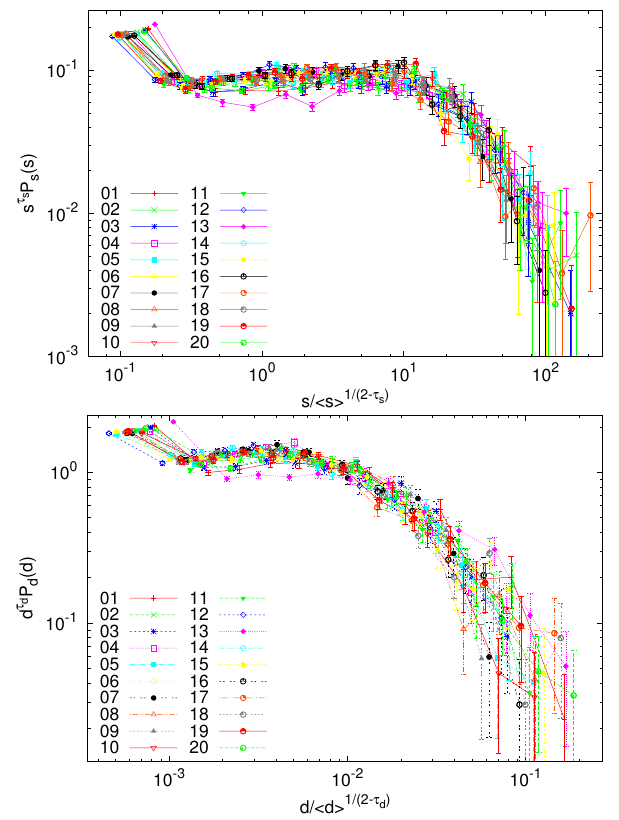
Fig. 5. Inferred scaling functions G S and G D (except for a propor- tionality factor in the x axis) corresponding to the rescaled distribu- tions of s and d in Fig. 4, multiplied by s τ s and d τ d . Units in the abscissae are as in the previous plot, whereas in the ordinates these are mm τ s − 1 and min τ d − 1